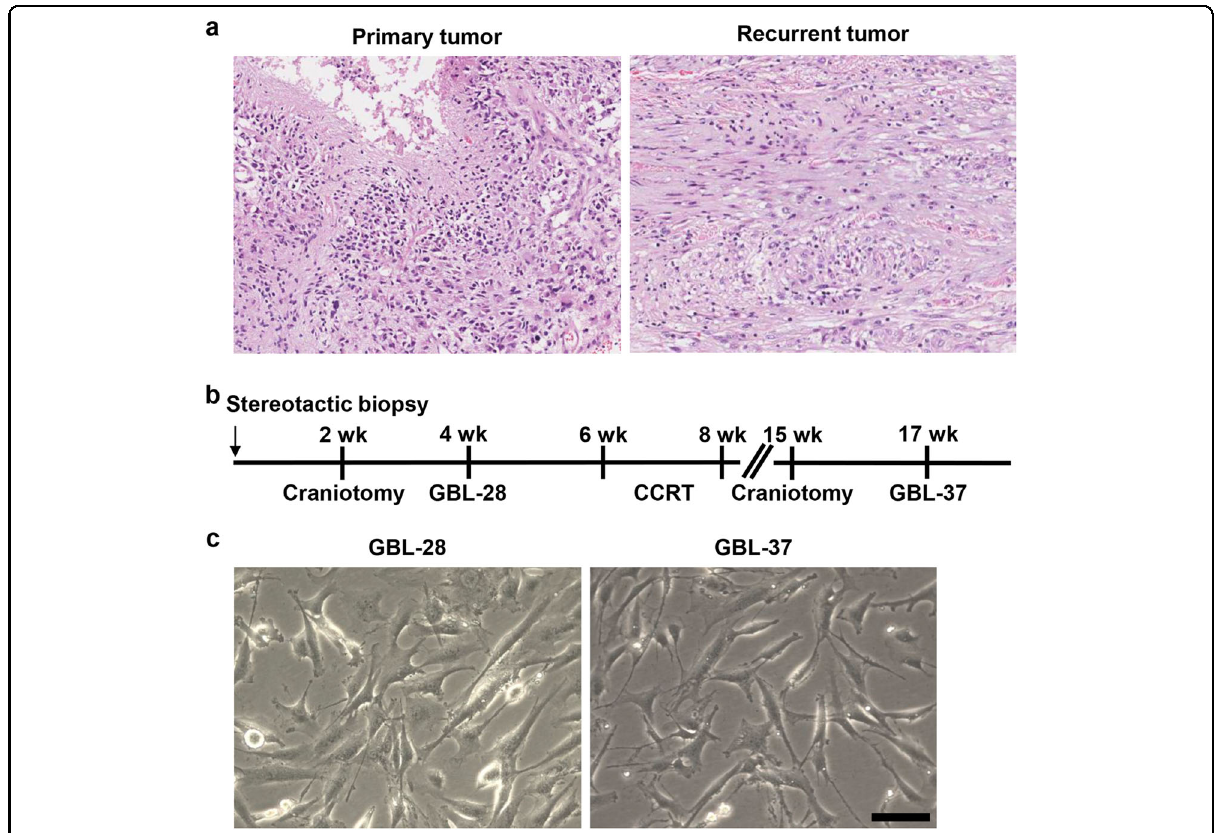
Fig. 1 Isolation and culture of tumor cells from a patient with primary and recurrent glioblastoma. a Representative images of the H&E- stained sections of the primary and recurrent tumors (original magni fi cation, 50×). b A schematic schedule of the stereotactic biopsy,